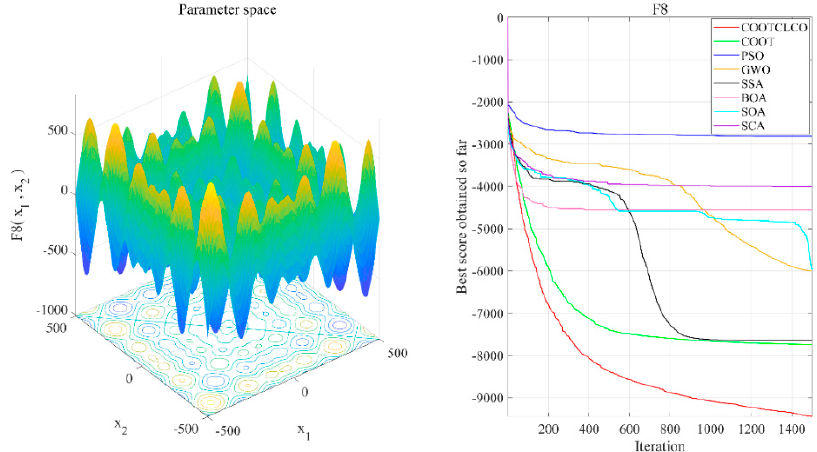
Figure 8. Test function F8 and comparison of convergence curves on F8.